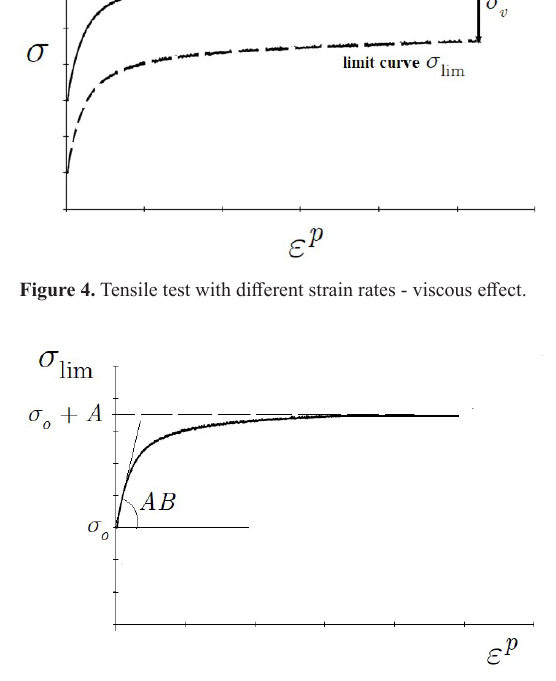
Figure 5. Schematic representation of the parameters